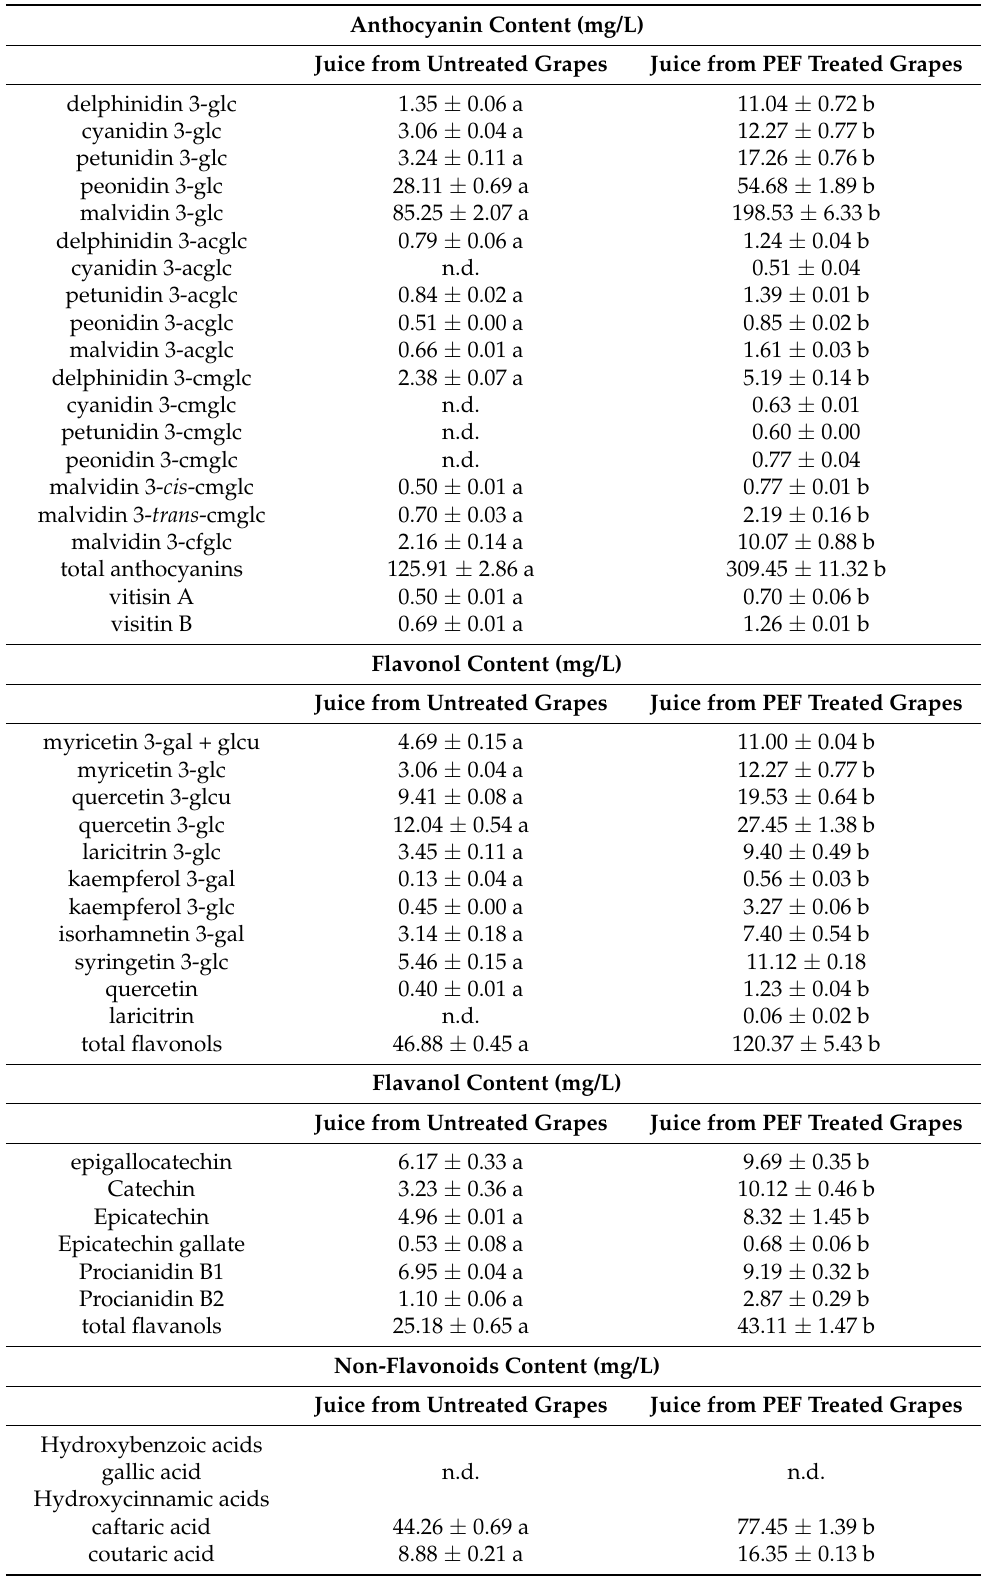
Table 2. Individual anthocyanin, flavanol, flavonol, and non-flavonoid content (mg/L) in grape juices obtained from untreated and PEF-treated grapes after 24 h of maceration at 4 ◦